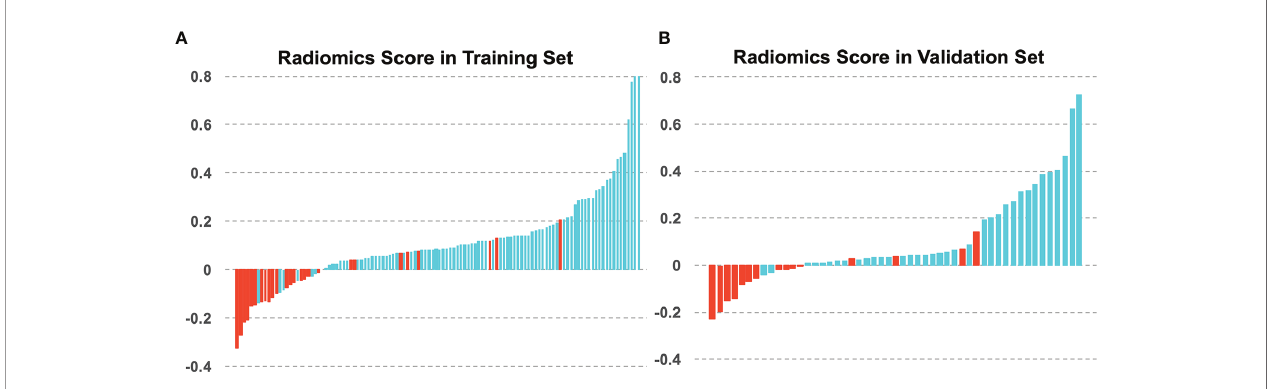
FIGURE 4 | The radiomics scores of each patient in (A) the training set and (B) the validation set, with blue for 5-year OS and red for 5-year